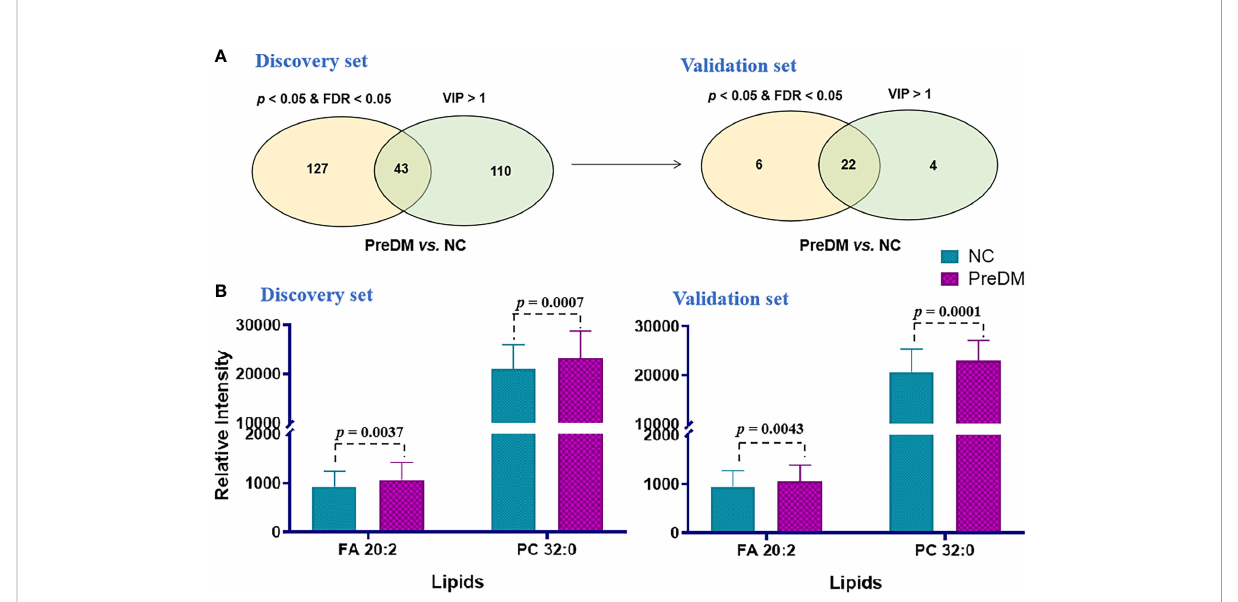
FIGURE 3 (A) Venn diagram of signi fi cantly differential lipids based on NC and PreDM. (B) Histograms of potential lipid markers in NC and PreDM specimens. Data are presented as mean ± SD.